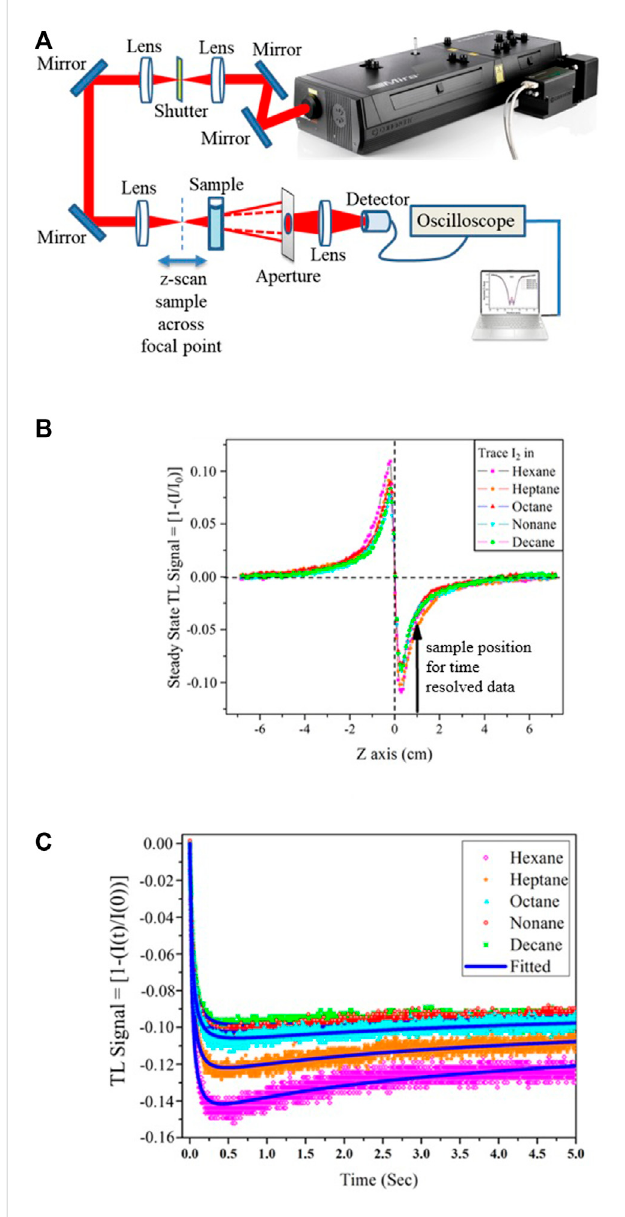
FIGURE 8 Femtosecond thermal lens (TL) spectroscopy with single laser beam: (A) Experimental setup for both stationary as well as time- resolved single beam femtosecond TL studies. (B) Typical steady-state TL signals for single-beam experiments as a function of sample position across the focal point of the TL-inducing laser for various samples showing zero-crossing at the focal point. For time-resolved TL collection, a position other than the focal point indicated by the arrow is chosen. (C) Time-resolved TL signals for Single beam femtosecond TL studies for the same shutter opening window. The early-time diagnostics of the shutter open part shows the importance of early time versus steady state. Note that for alkane samples, where the thermal effect is low, I 2 was added to keep the extent of TL generation steady across different samples. Fitting of the data is possible with Eq. 2, as discussed in the